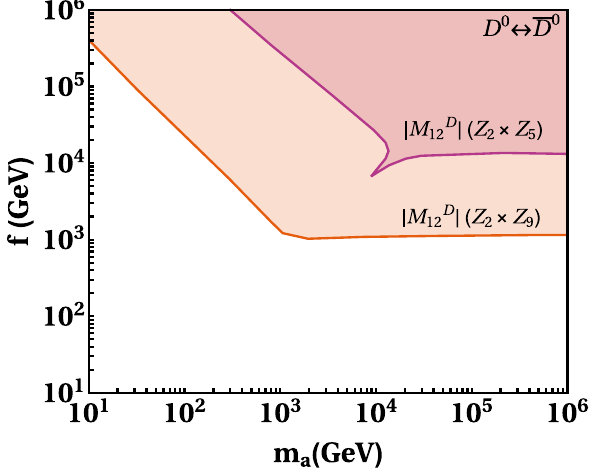
Fig. 5 The allowed parameter space by | M D f plane for the minimal ( Z 2 × Z 5 ) model is shown by the magenta coloured boundary while that for the non-minimal ( Z 2 × Z 9 ) model is shown by the red coloured boundary